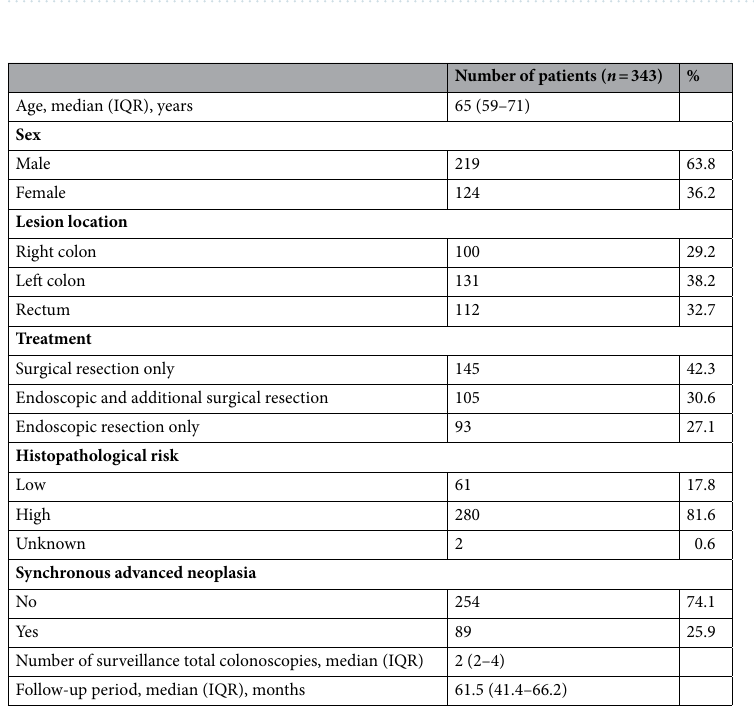
Figure 1. Flowchart of the study population. SM-CRC submucosal invasive colorectal cancer, CRN colorectal neoplasia, TCS total colonoscopy.